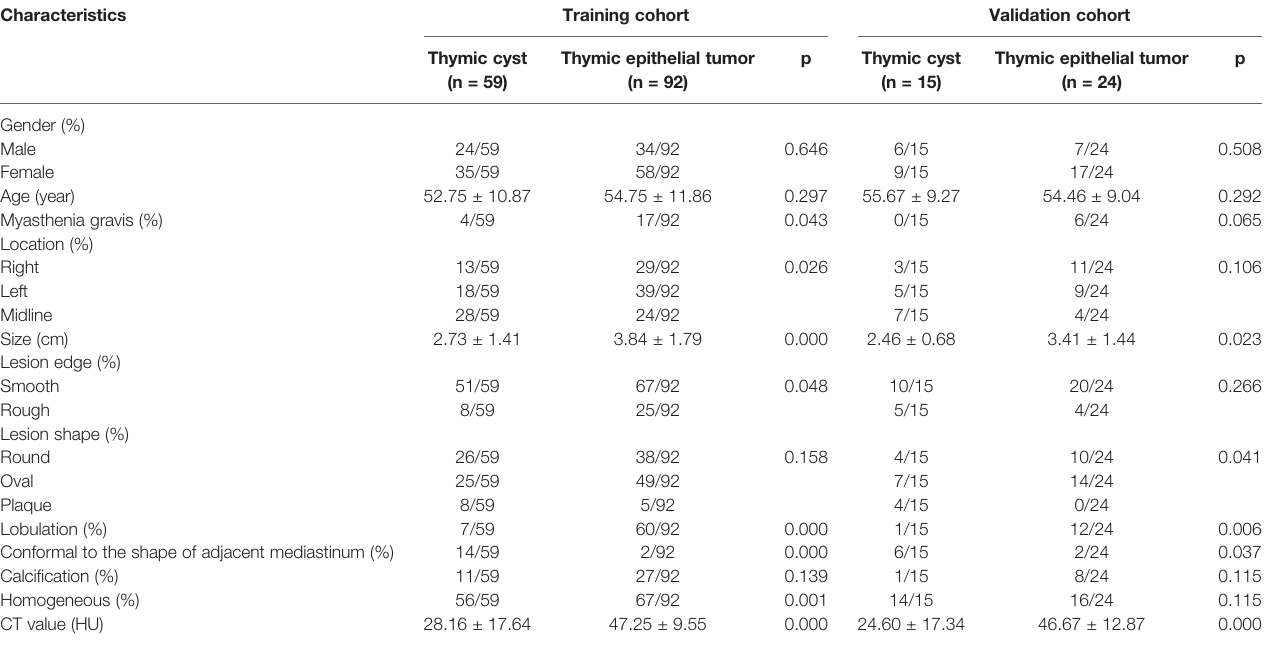
TABLE 1 | The patients ’ characteristics and conventional CT fi ndings of the two cohorts.